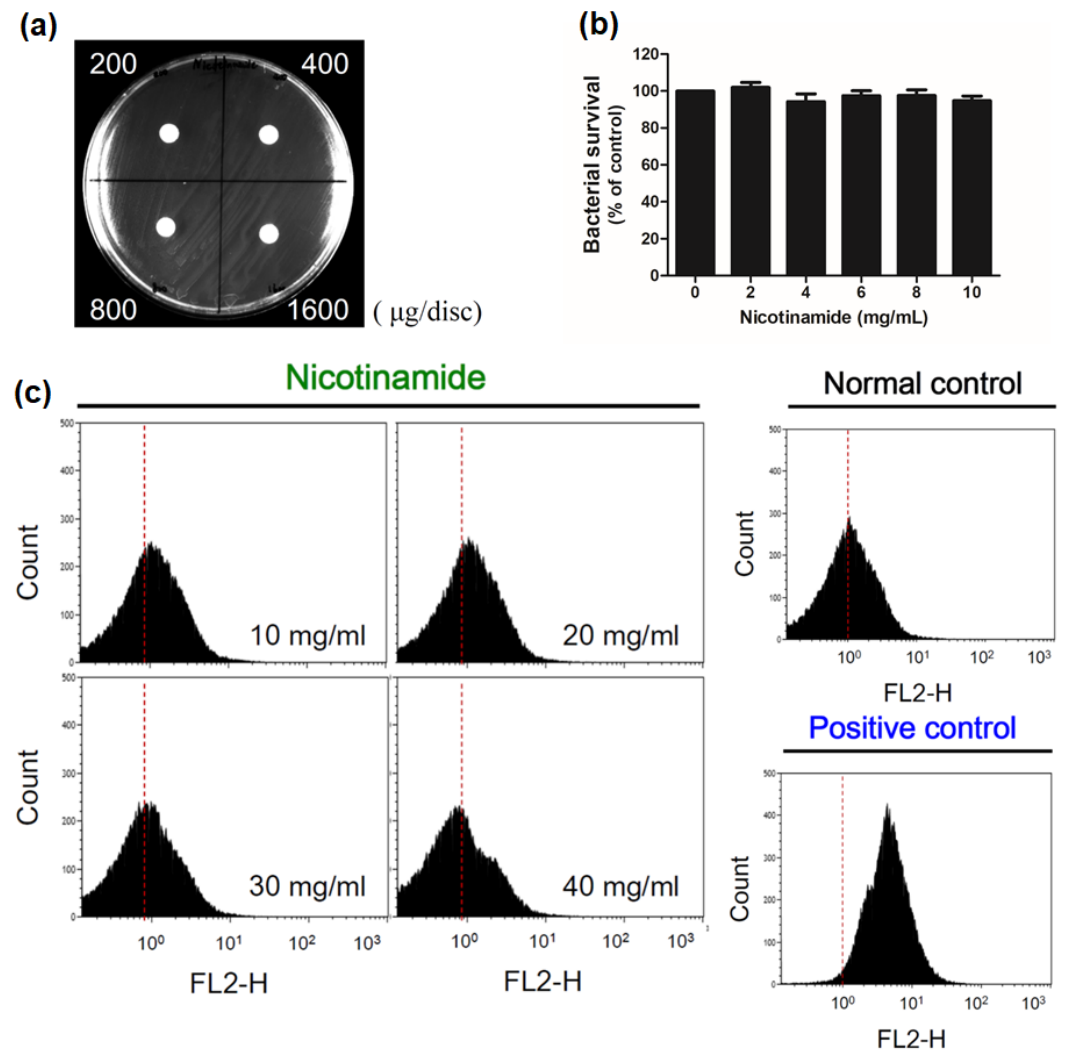
Figure 4. Nicotinamide (NAM) shows no antibacterial activity at the tested dosages. ( a ) An agar diffusion test showing that NAM did not inhibit the growth of Cutibacterium ( C. ) acnes at dosages of <1600 µ g/disc. ( b ) A bacterial suspension of C. acnes was treated with NAM at the indicated dosages. No effect on bacterial growth was detected at dosages of <10 mg/mL; n = 3 (mean ± SEM). ( c ) Flow cytometry with propidium iodide staining did not show a shift to the right, suggesting that there was no remarkable cell death after NAM treatment at dosages of <40 mg/mL. Normal control: C. acnes with no treatment. Positive control: C. acnes exposed to high temperature (75 ◦ C) for 30